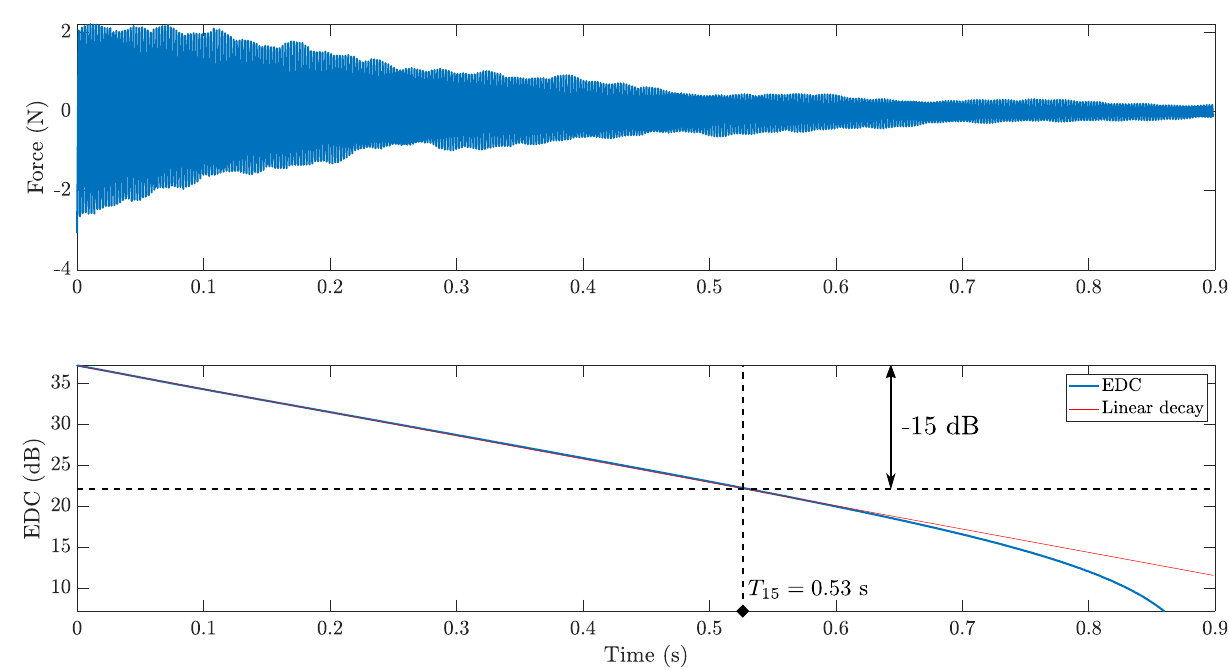
Figure 7. Example of energy decay curve (bottom) computed from the force applied by the A4 string to the soundboard of the reference piano (top). The linear part of the EDC (red solid line), obtained by linear interpolation, is used to compute the decay time T 15 .